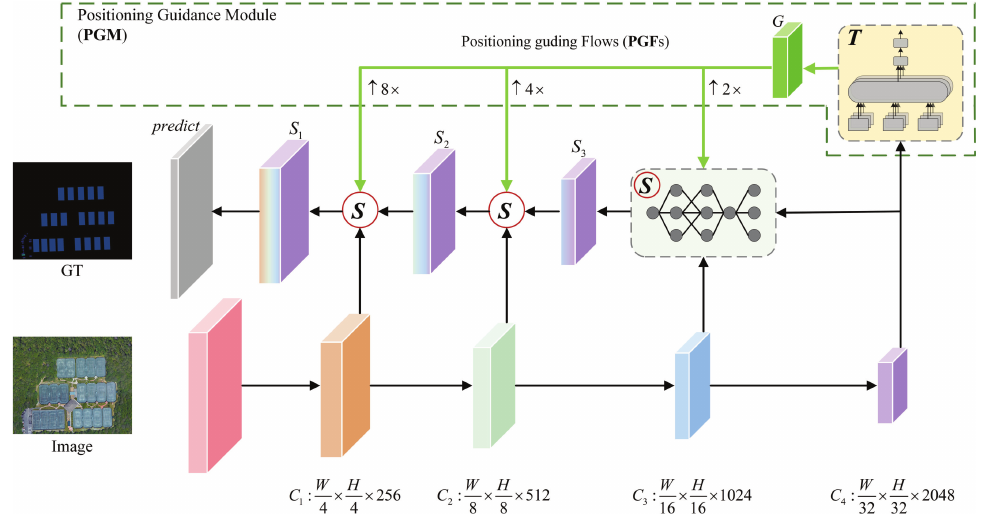
Figure 2. The framework of the proposed PGNet, which consists of a Res2Net backbone, a positioning guidance module (PGM) and three self-multiscale collection modules (SMCM). T means transformer block and S means